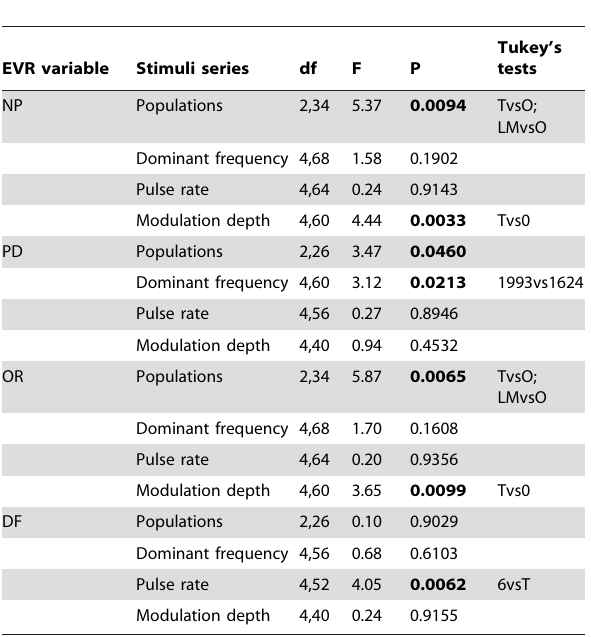
Table 3. Repeated measures GLMs and Tukey’s tests for EVR variables (NP, DP, OR and DF) within four series of stimuli presented to males from the Totoral population of P. thaul .